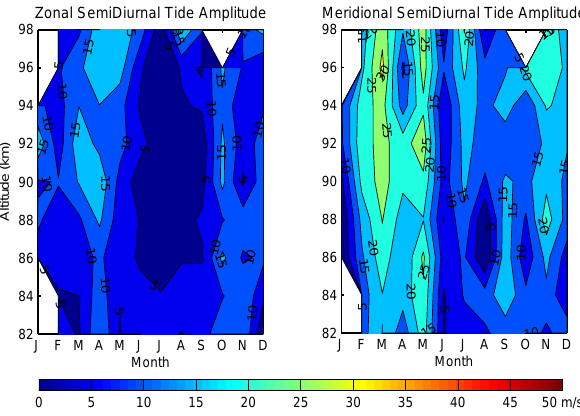
Fig. 6b. Same as Fig. 6a, but for semidiurnal